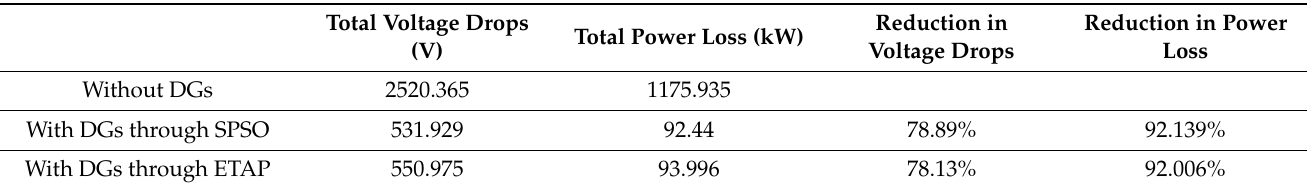
Table 5. Accumulative voltage drops and power loss comparison in different situations.